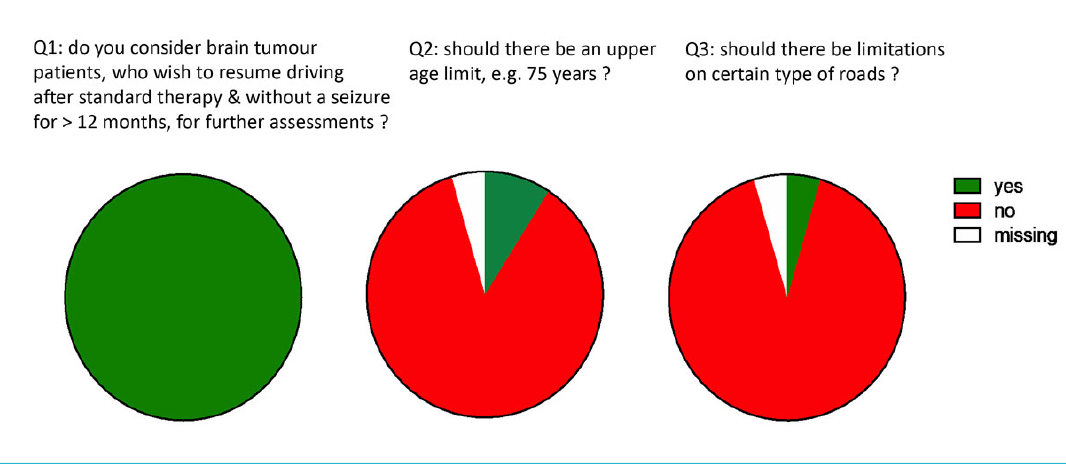
Table 2: Criteria considered incompatible with driving. Criteria Panellists ( n =